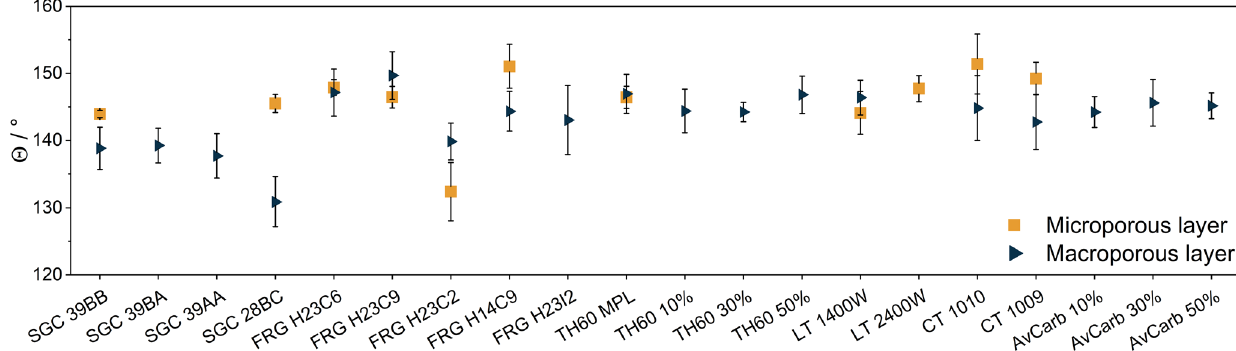
Fig. 3 Wetting properties of different commercially available carbon gas diffusion layers. Contact angles measured with 10 µ l 0.1 M CsOH solution. Each data point and standard deviation is calculated from results measured for at least 5 separate liquid droplets. The results for the microporous layer are denoted with yellow squares, for the macroporous layer with blue triangles.